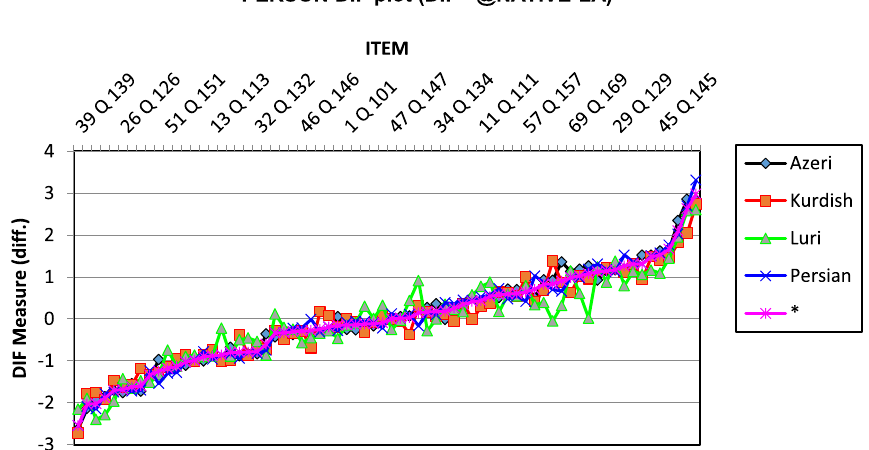
Fig. 5 Uniform differential item functioning in the Iranian Undergraduate University Entrance Special English IUUESEE